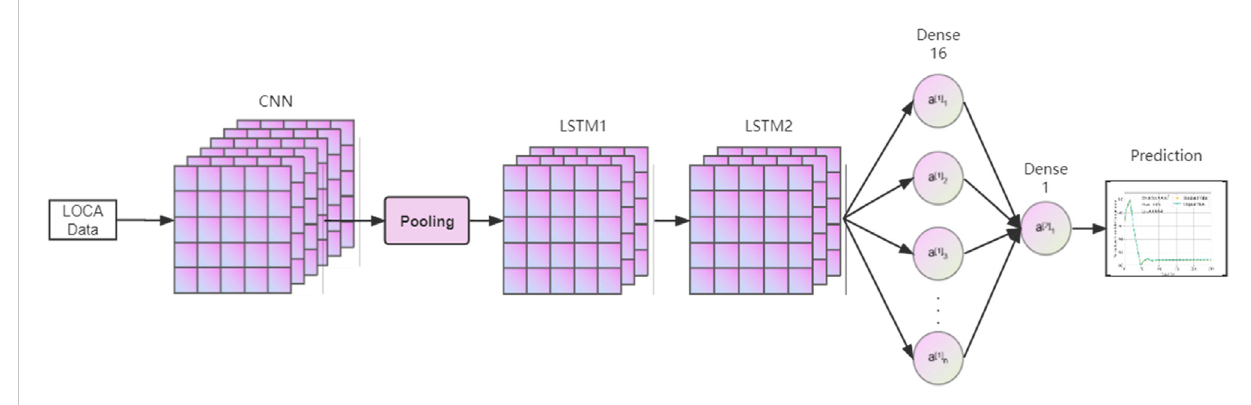
FIGURE 2 CNN + LSTM structure.